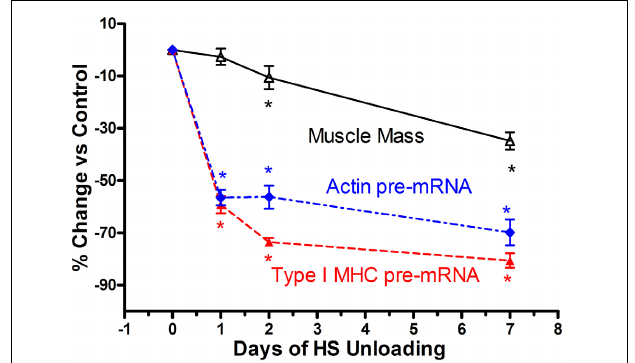
FIGURE 6 | Muscle atrophy in antigravity muscle is rapid and preceded by transcriptional repression of myosin and actin. Change in soleus mass, actin and type I MHC pre-mRNA in response to 7 days hindlimb suspension (HS) unloading. ∗ is for p < 0 . 05 vs. 0 Day time point for each